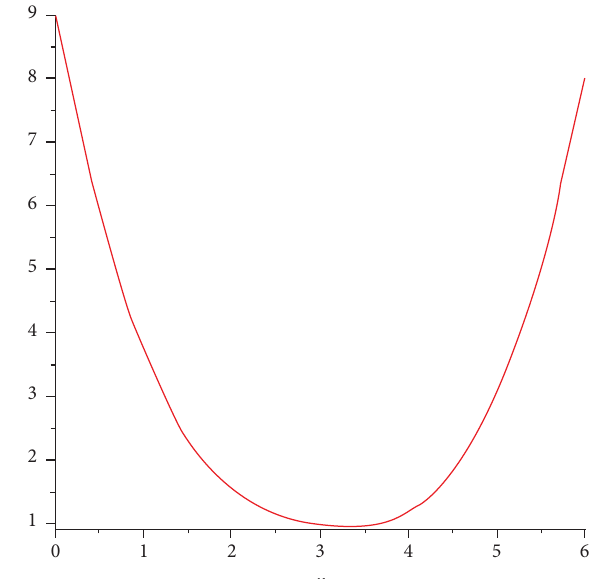
Figure 4: Location of the points.